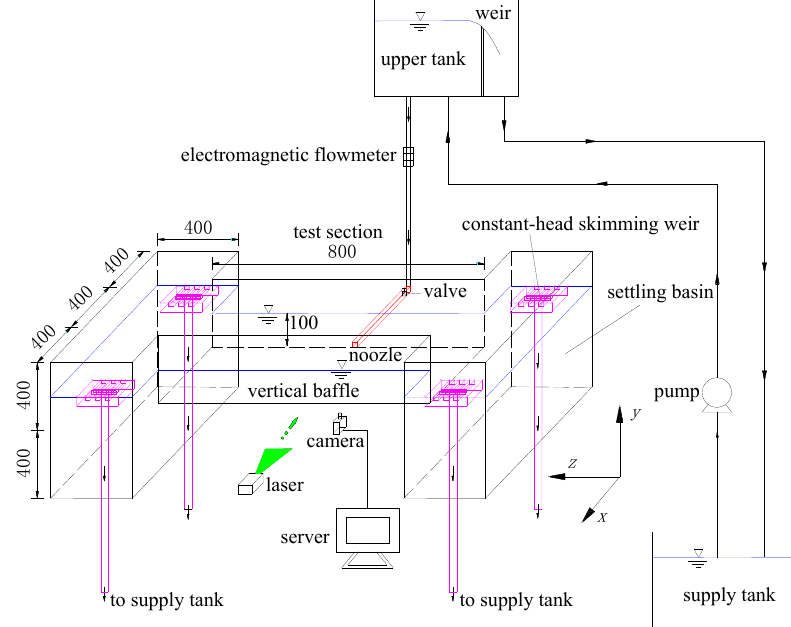
Figure 2. A sketch of experimental setup. (All dimensions in mm).